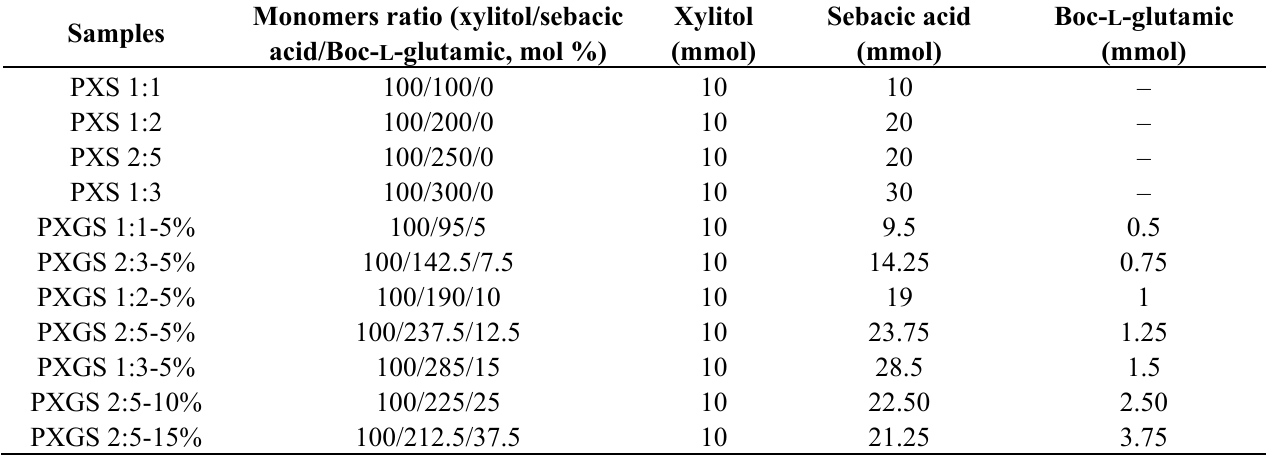
Table 1. The feeding monomer ratio and amount for synthesis of poly(xylitol glutamate monomer ratio of xylitol: dicarboxylic acid of x:y, and the content of Boc- L -glutamic acid in dicarboxylic acid was